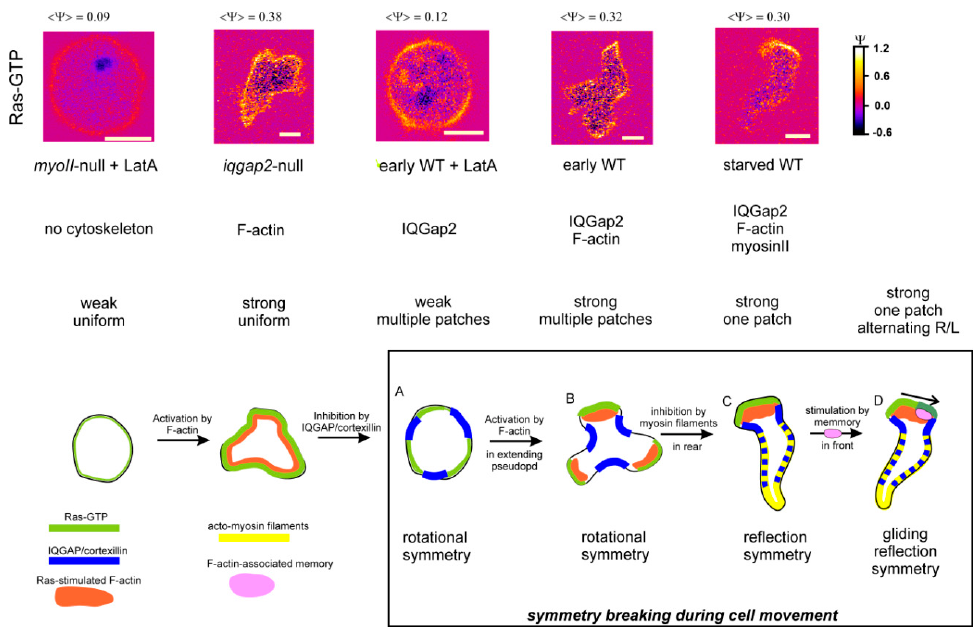
Figure 2. Symmetry and symmetry breaking of Ras-GTP localization in a series of mutants in the absence and presence of the F-actin inhibitor LatA. The mutants are ordered so they form a sequence of symmetry breaking. Top shows images of representative cells. < Ψ > is the average fluorescence intensity at the boundary of the cell (see [4] for definition). Bottom shows schematics with the localization of key components to establish the different forms of symmetry. The box represents the symmetry forms and transitions in wild type Dictyostelium cells. The figure is redrawn from [5].